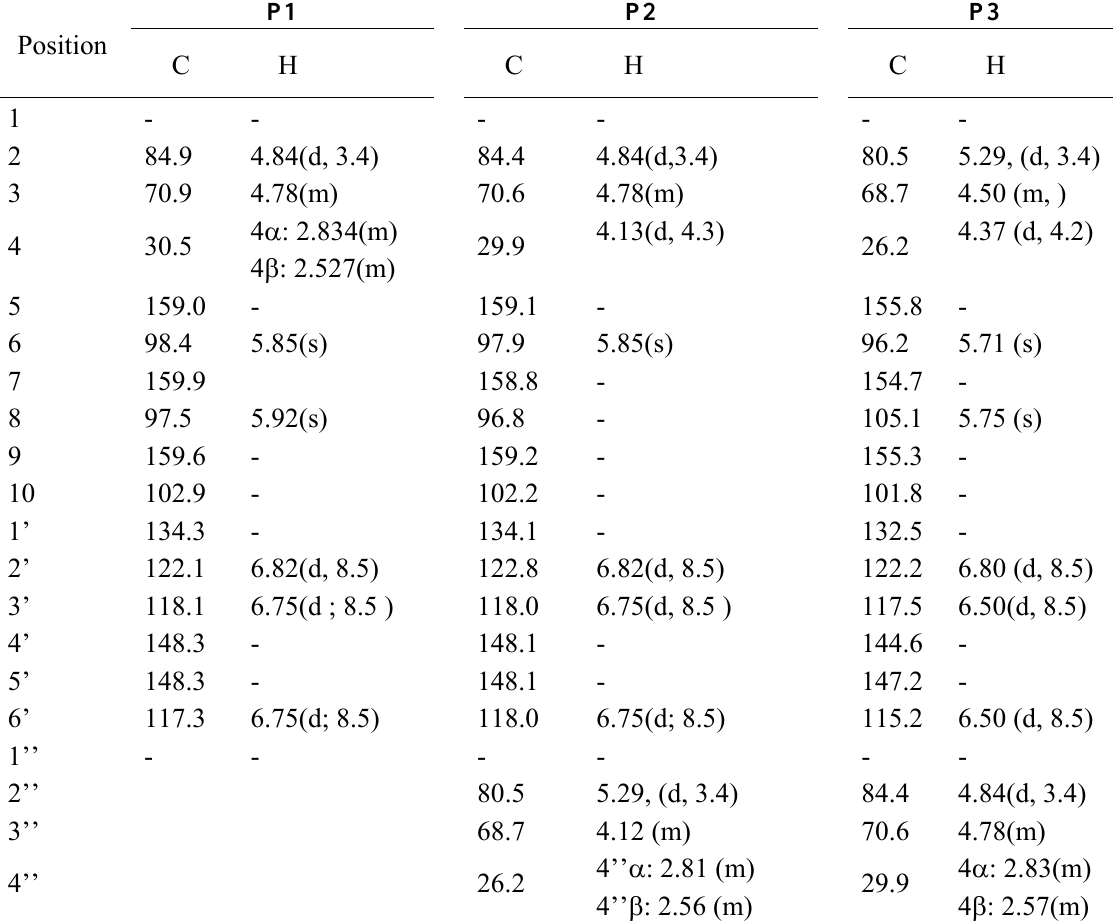
Table 1. 13 C- (125 MHz) and 1 H-NMR (500 MHz) spectroscopic data for P1 , P2 and P3. Chemical shifts are given in ppm; multiplicities and coupling constants J (in parentheses) in